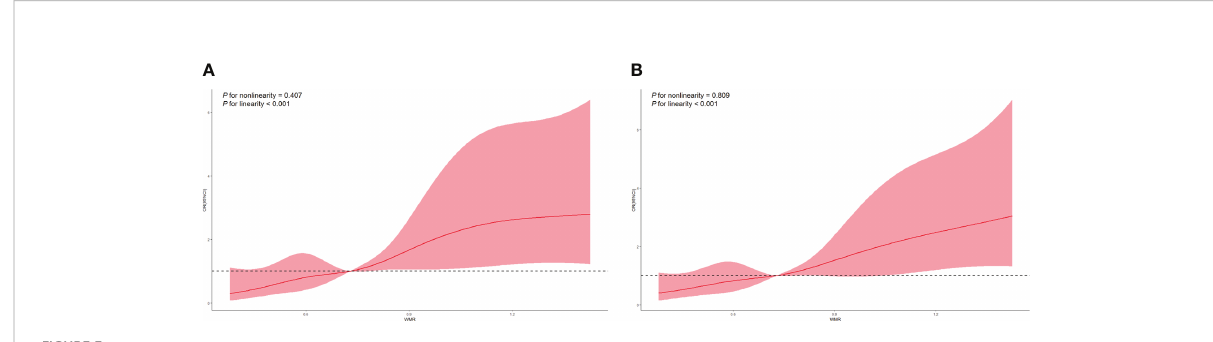
FIGURE 3 Restricted cubic spline regression analyses of WMR and poor outcomes. (A) mRS 3-6 at 3 months. (B) mRS 2-6 at 3